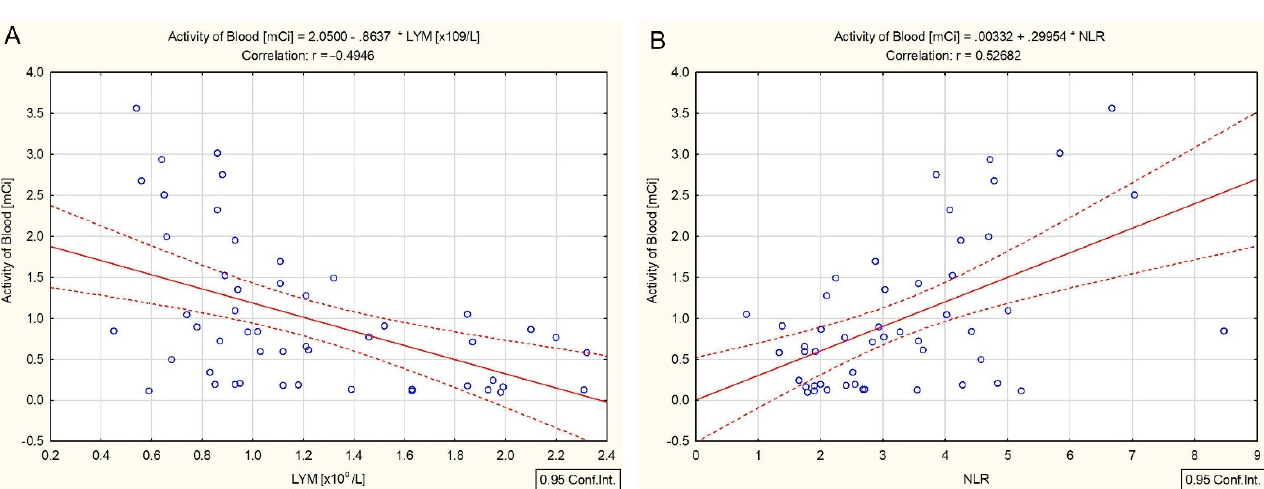
Figure 6. Correlation measured at 69 h post-administration between the whole blood activity and absolute lymphocytes count ( A ) and NLR ( B ).